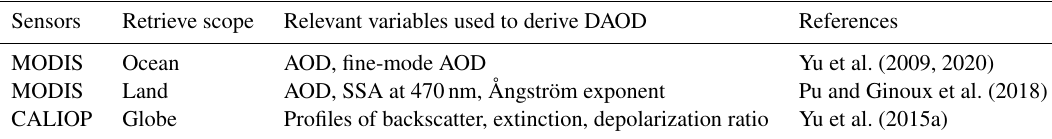
Table 1. Summary of DAOD retrievals from MODIS and CALIOP.